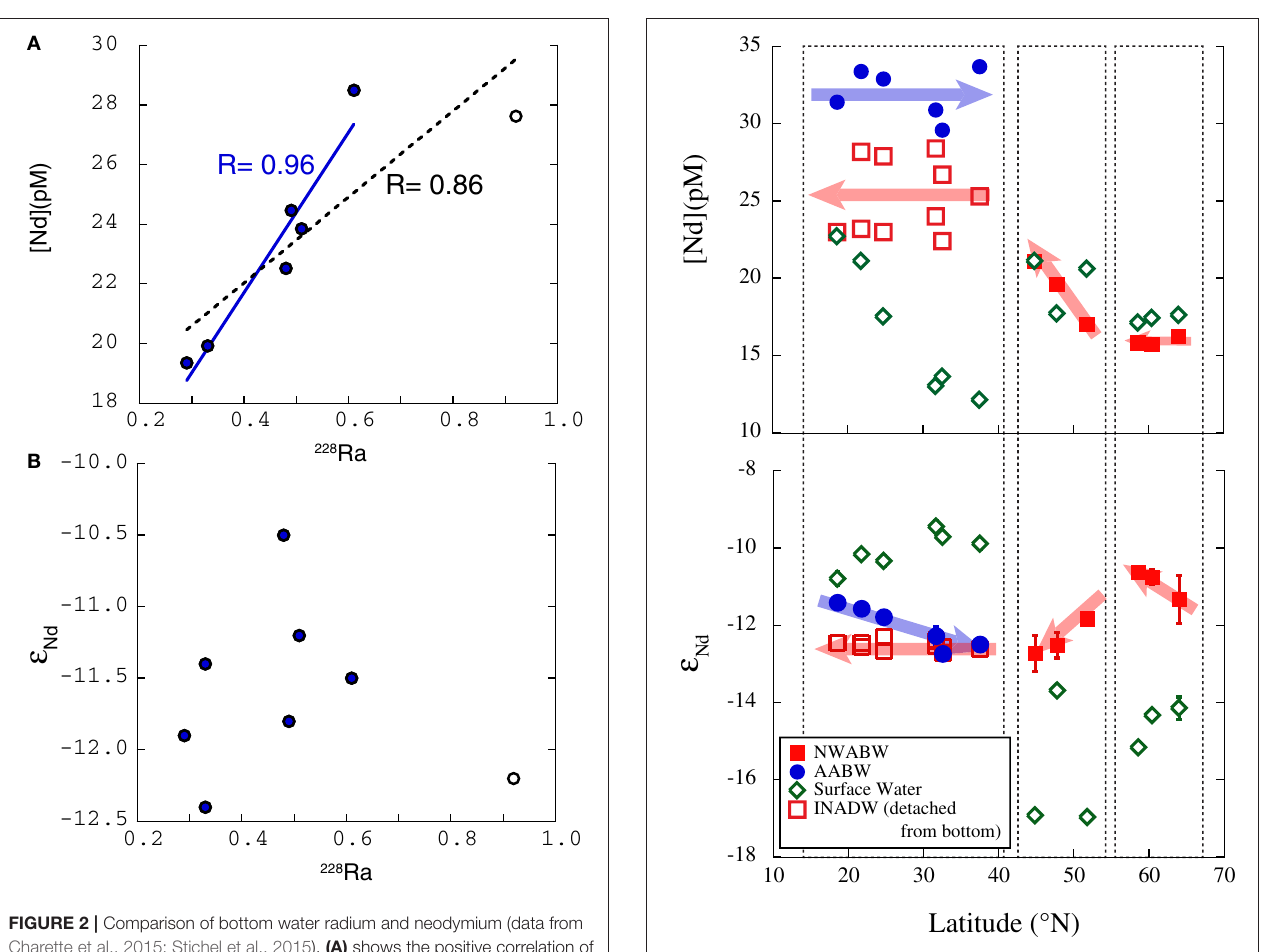
Abbott et al., 2015a; assuming flux of 20 pmol/cm 2 /yr with ε Nd of − 15, which is reasonable but arbitrarily chosen, and a deep water [Nd] of 15 pM, which is measured), we might estimate that the residual 1-unit corresponds to ∼ 35 years of benthic flux exposure on a 1 km thick bottom water layer, occurring over ∼ 12 ◦ latitude. This combination results in a bottom water current velocity of